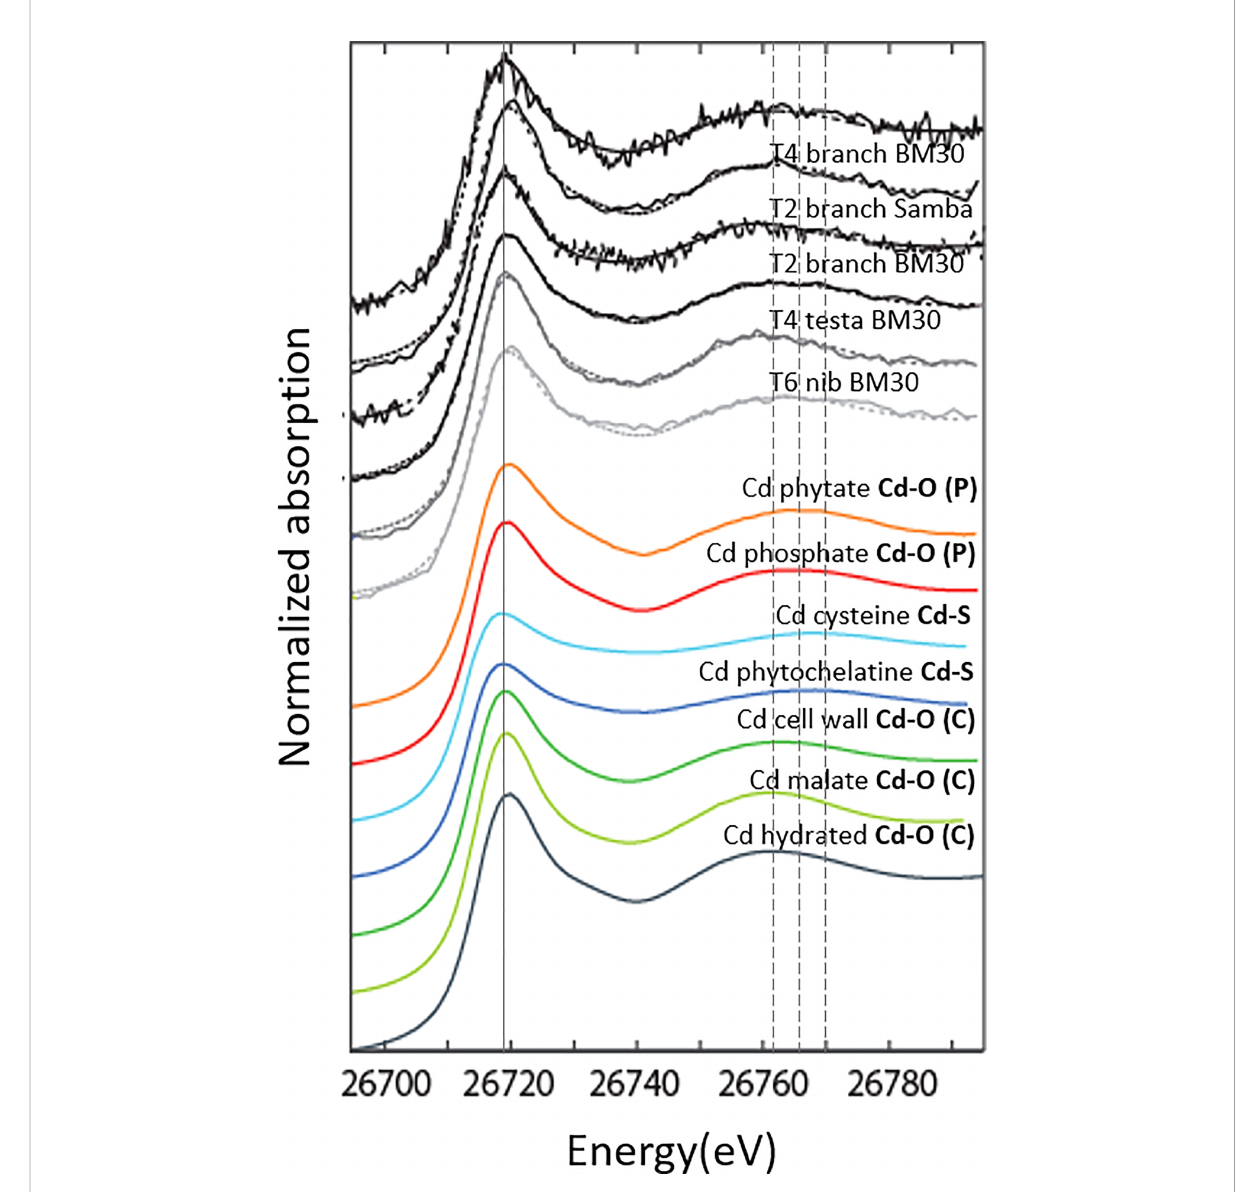
FIGURE 3 Cd K-edge XANES spectra of cacao tissues and of some Cd references. Cd-hydrated, Cd-malate, Cd-cell wall represent O (C)-ligands; Cd- phosphate and Cd-phytate represent O (P)-ligands, Cd-cysteine and Cd-phytochelatine represent S-ligands. The solid line is positioned at the white line energy (i.e. the intense absorption peak after the edge). The fi rst vertical dashed line is at the fi rst oscillation maximum for O (C)- ligands, the second dashed line for O (P)-ligands, and the third dashed line for S-ligands. Samples were either measured at ESRF, beamline BM30 or synchrotron Soleil, beamline